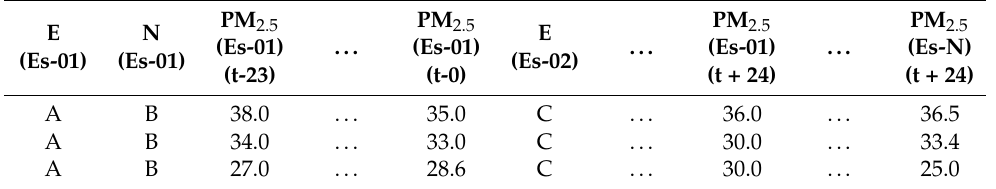
Table 3. Data structure expressed in time